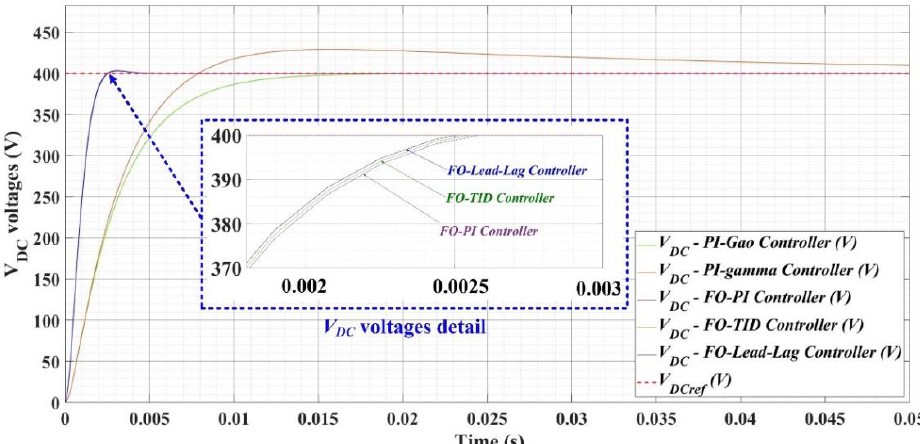
Figure 15. V DC voltage time evolution in the comparison of the PI-Gao, PI-gamma, FO PI, FO TID, and FO lead-lag voltage controllers for the control system of the power electronic converter.